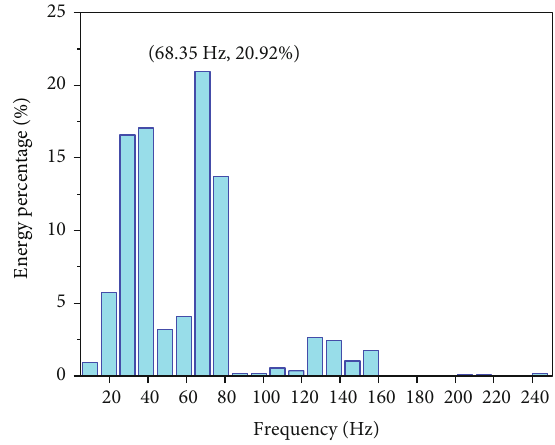
Figure 7: The energy spectrum of blasting